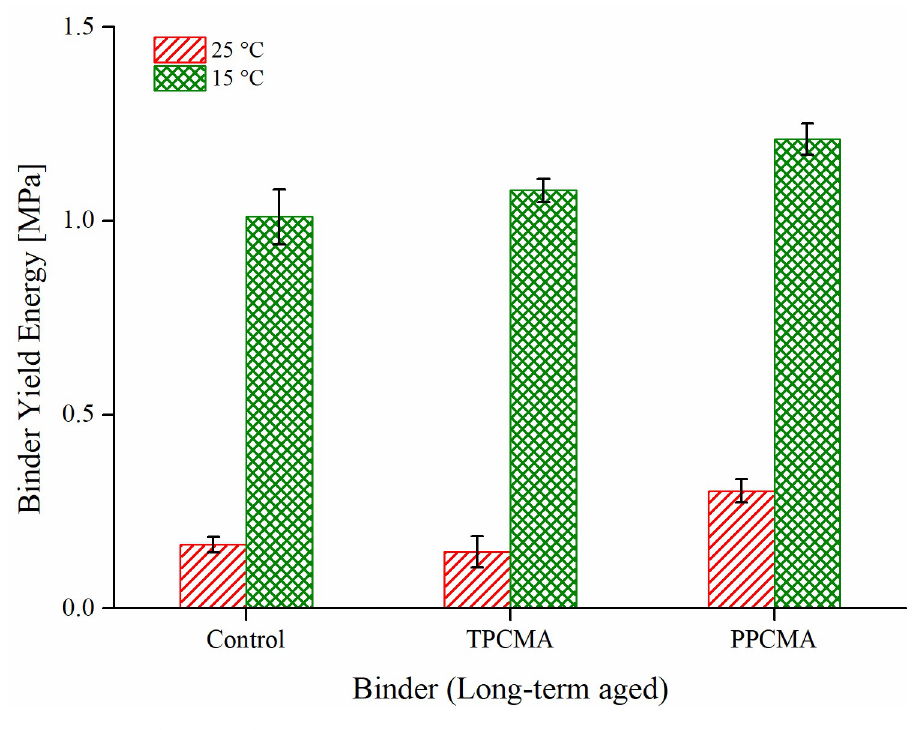
Fig 11. BYET results at 15 and